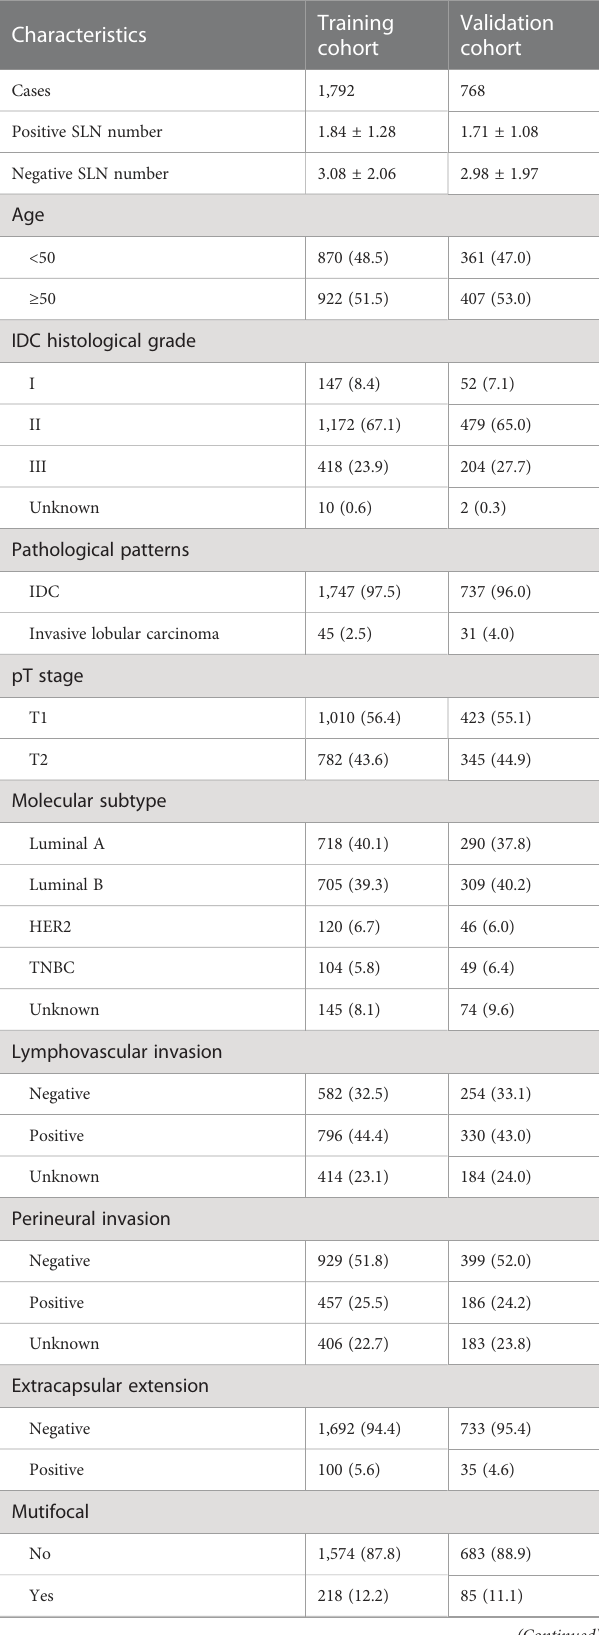
TABLE 1 Clinical and pathological characteristics of the training cohort and the validation cohort.